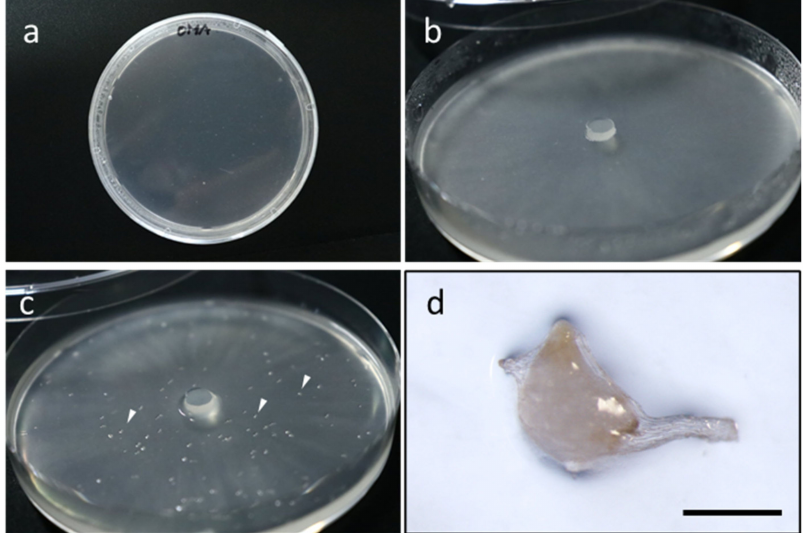
Figure 1. Preparation of in vitro symbiotic germination assay. ( a ) A plain oatmeal agar (OMA) plate. ( b ) A piece of fungal inoculum is put at the center of the plate. Hyphae will appear as a thin, whitish layer on the medium. ( c ) Surface-sterilized seeds (arrowhead) sown on top of the hyphal layer. ( d ) Symbiotically germinating Bletilla striata seed during inoculation with Tulasnella sp. after two weeks. Scale bars, 500 µ